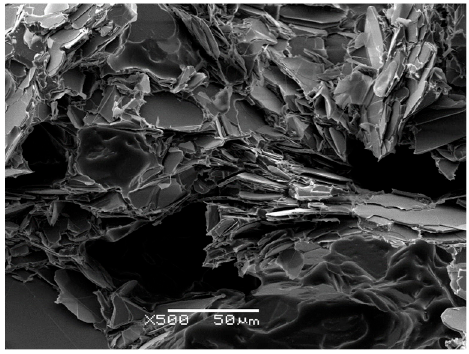
Figure 13. SEM micrograph of an epoxy-composite, EJBN30-60. Magnification 500×, scale bar 50 μ m.